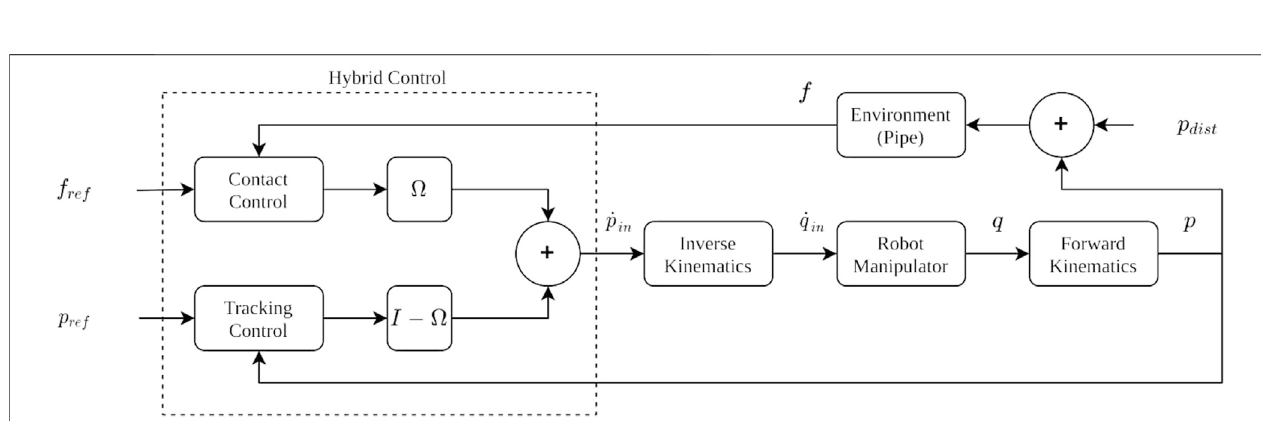
FIGURE 1 | Illustration of the end effector attached with a force sensor of the mobile-based manipulator interacting with a pipe in the presence of disturbance effects on the base vehicle.